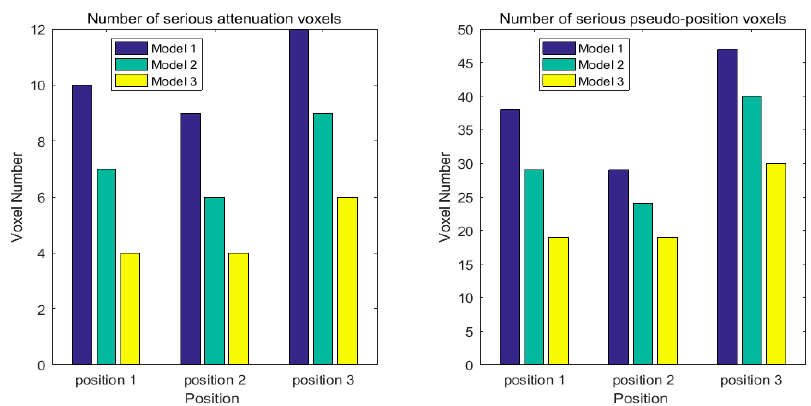
Figure 8. Positioning performance from reconstructed images.